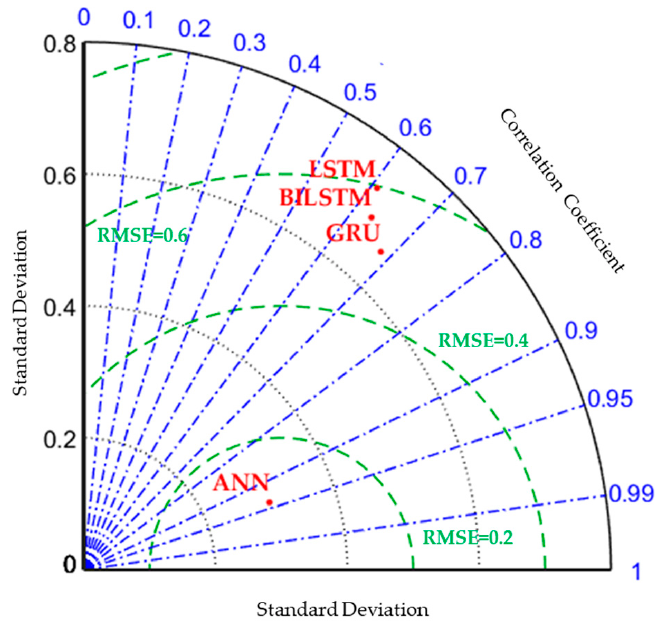
Figure 10. Taylor diagram for ANN, LSTM, GRU, and Bi-LSTM models.